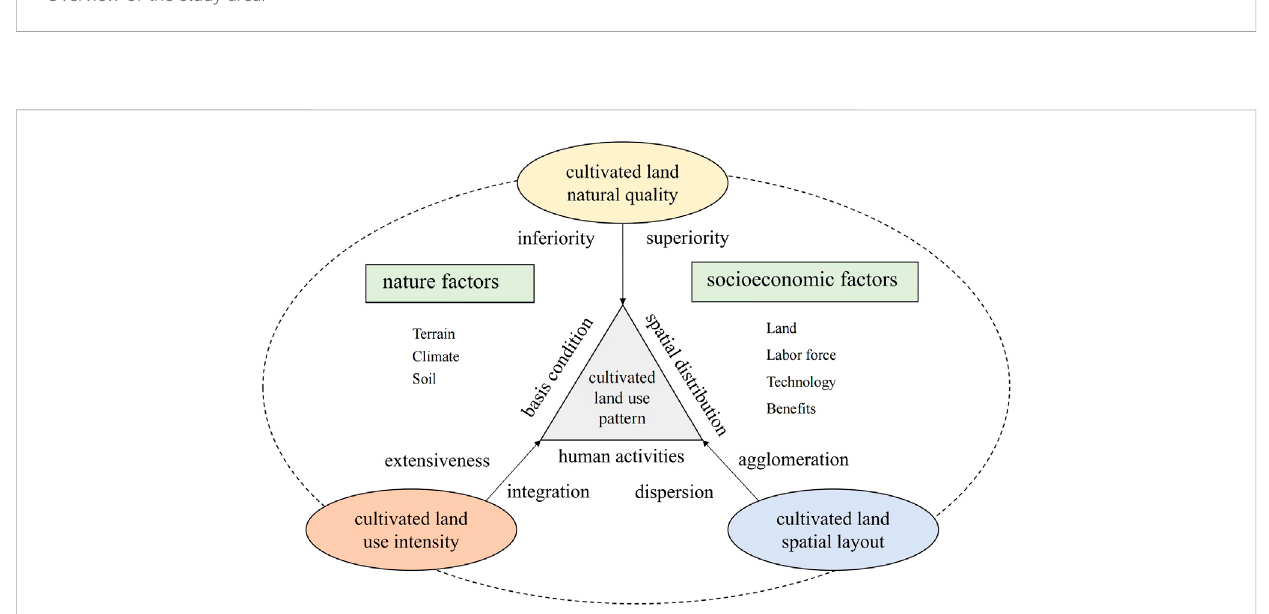
FIGURE 1 Overview of the study area.